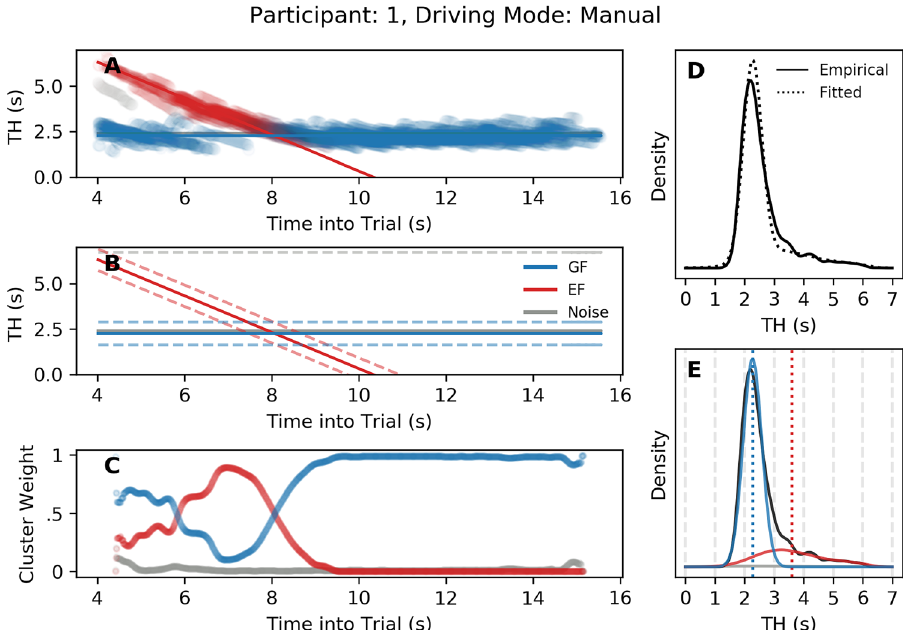
Figure 6. Model fit. A sample participant’s model fitting results. ( A ) Gaze data, with gaze Time Headway (TH) along the ordinate and Time into Trial along the abscissa. Gaze fixation data are shaded according to the probabilities of belonging to Guiding Fixations (GF; blue), Entry Fixations (EF; red) or Noise (Grey) clusters. ( B ) The regression lines and standard deviations of each model, from which a weighted sample is taken. ( C ) Smoothed cluster weights across the track. ( D ) Raw gaze TH density (solid black) overlaid with the fitted gaze TH density (dotted black). ( E ) The fitted gaze TH density decomposed into mixtures of GF (blue) and EF (red). Vertical dotted lines represent the estimated means.